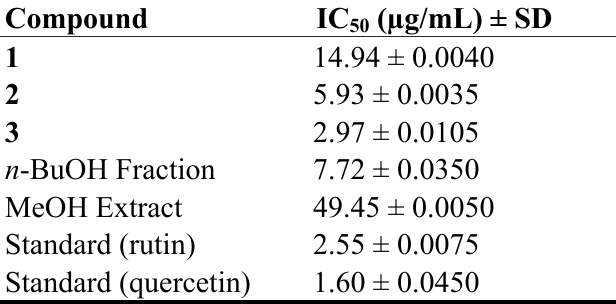
Table 1. Antioxidant activity (IC isolated flavonoids of M. albicans